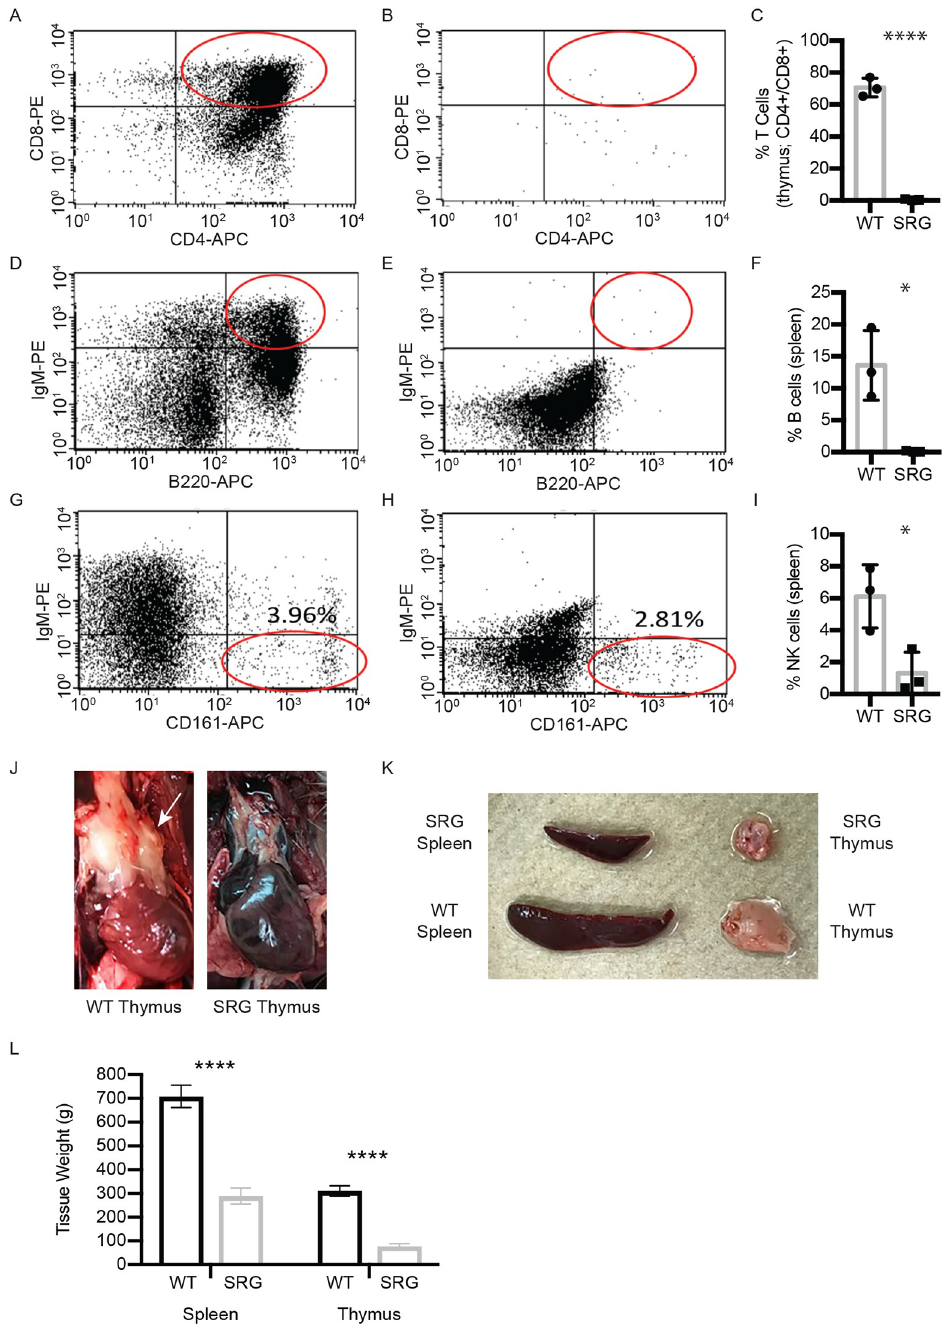
Fig 1. Immunophenotyping of thymocytes and splenocytes in the SRG rat. A-C) CD4+/CD8+ mature T cells in A) wild type control and B) SRG rat thymocytes. C) Quantification of data, n = 3, error ± SD. (Unpaired t-test, p-values: ���� < 0.0001). CD4+/CD8+ mature T cells are absent from SRG thymocytes, compared to a wild-type control. The lack of thymus tissue in the SRG rat results in a low recovery of viable thymocytes. D-F) CD45R (B220)+/IgM+ cells in D) wild-type spleen and E) the SRG spleen. F) Quantification of data, n = 3, error ± SD. (Unpaired t-test, p-values: � < 0.05). Compared to B cells in a wild-type spleen, the SRG spleen contains no mature B cells as demonstrated by lack of CD45R (B220)+/IgM+ cells. G-I) NK cells in G) wild-type rat spleen and H) SRG rat spleen. I) Quantification of data, n = 3, error ± SD. (Unpaired t-test, p-values: � < 0.05). NK cells in the SRG rat spleen (H) are similar to or less than the amount of NK cells in the wild-type rat. The Il2rg knockout in the SRG rat results in significantly fewer NK cells than the single Rag2 knockout rat [8]. J) Image of wild-type Sprague Dawley versus SRG thymus. K) Images of wild-type